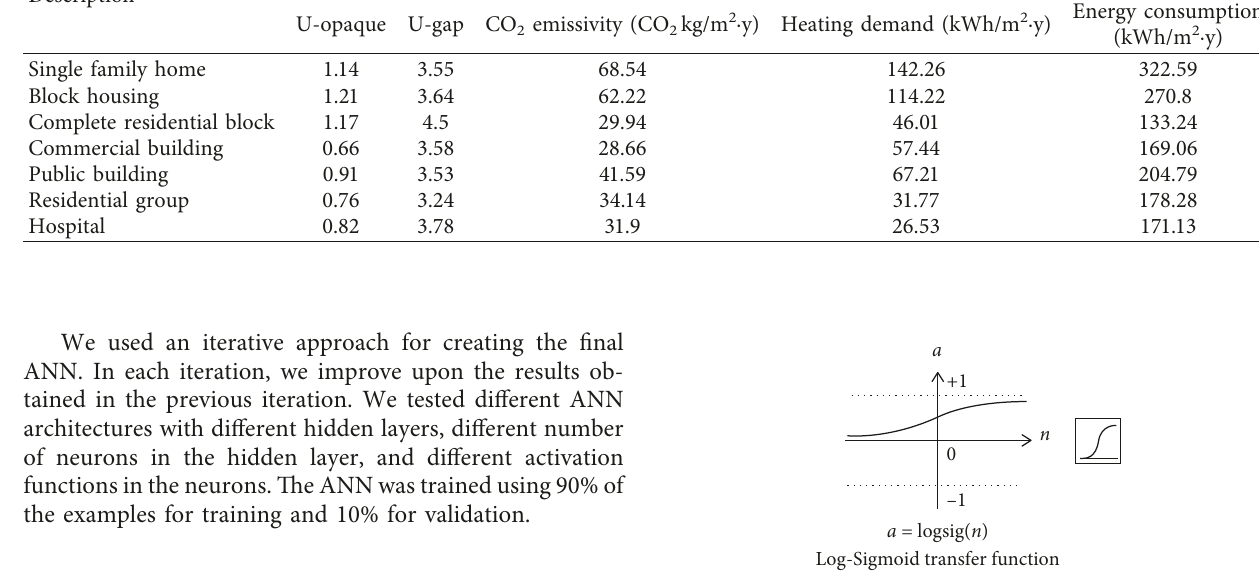
Figure 1: Activation function that produces the best